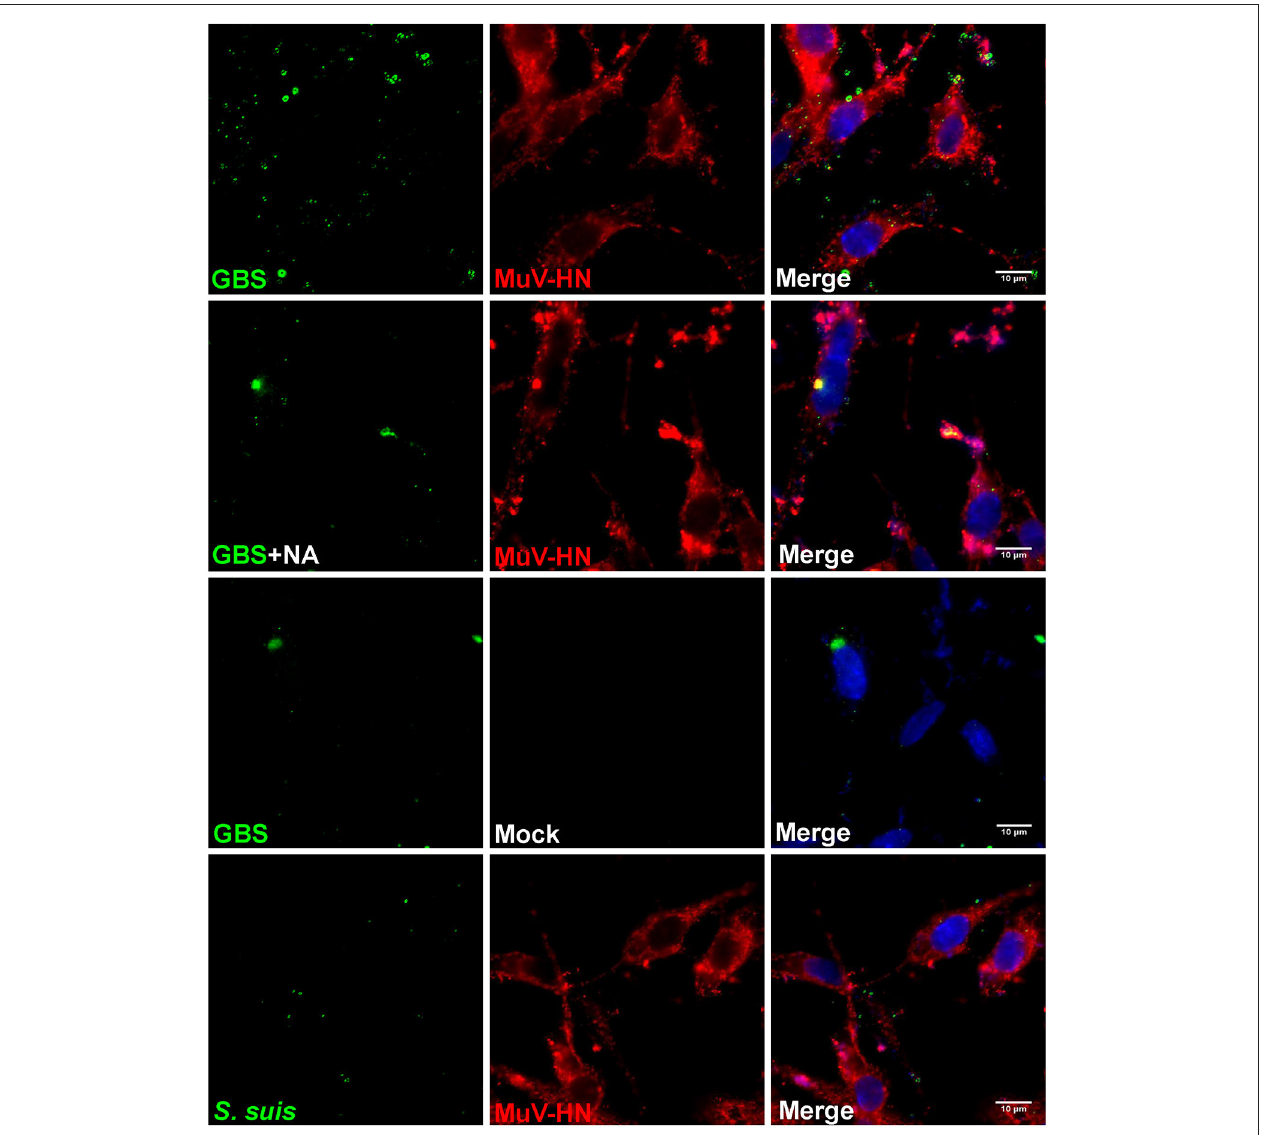
FIGURE 5 | Immunofluorescence analysis of streptococcal attachment to HN-expressing cells. HEp-2 cells were transfected for expression of MuV-HN protein. At 24h p.t., GBS (with or without NA-treatment) or S. suis were inoculated onto the cells at 4 ◦ C for 1h. Cells expressing no MuV-HN protein are indicated as “mock.” After adherence of bacteria, cells were immuno-stained for MuV-HN (red), bacteria (green), or nuclei (blue) and analyzed by fluorescence microscopy (scale bar: 10 µ